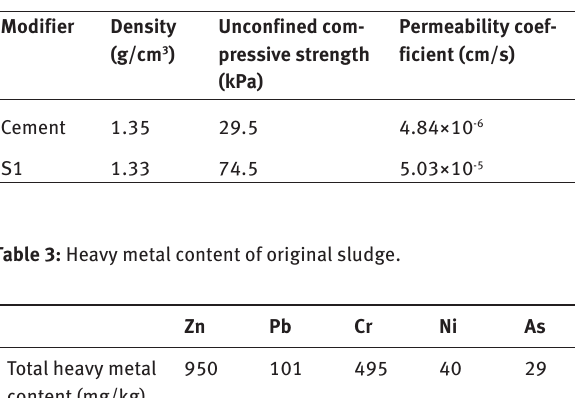
Table 2: Mechanical properties of modified sludge.